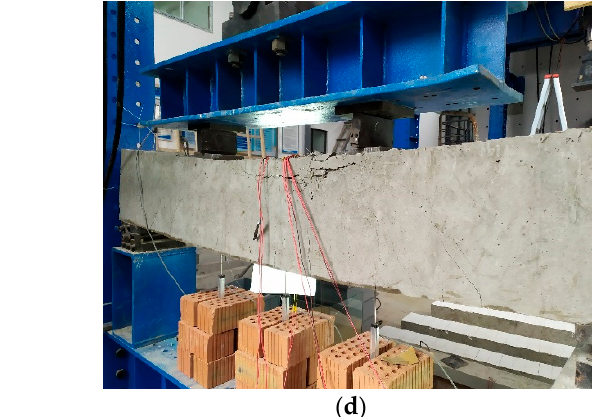
( d ) Figure 5. Beam L-1-30 experimental phenomena. ( a ) Development of cracks on the front of beam L-1-30; ( b ) the concrete on the upper part of the beam L-1-30 is crushed; ( c ) a through crack at the bottom of beam L-1-30; ( d ) development of cracks on the back of beam L-1-30. The concrete mechanical properties ( f cu is compressive strength, and f t is split tensile strength), cracking load, and ultimate load of each beam are shown in Table 5. Table 5. Concrete mechanical properties, cracking load, and ultimate load of specimens.